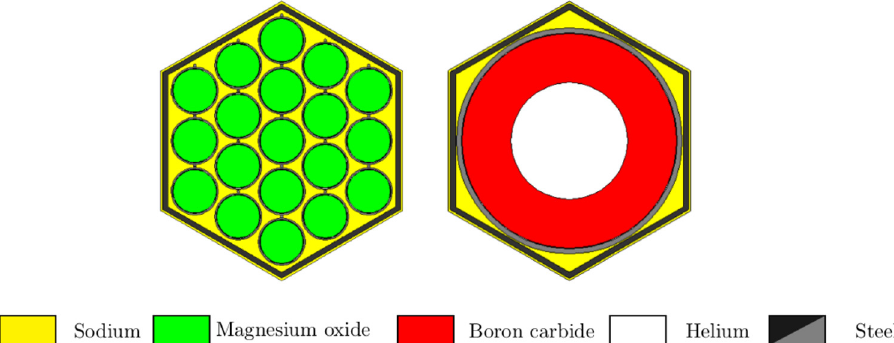
Fig. 3. Description of the re fl ector (left) and shielding (right) assemblies (assembly pitch is 17.17